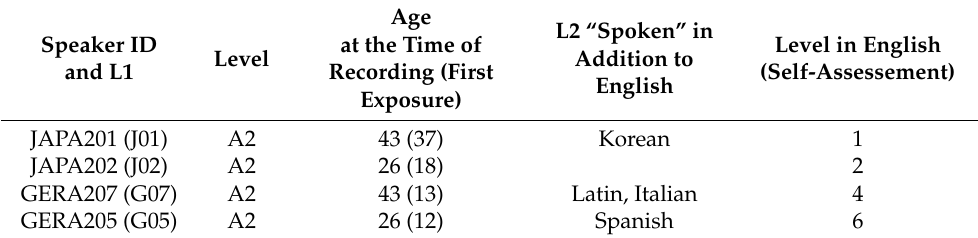
Table 3. Participants chosen for the pilot